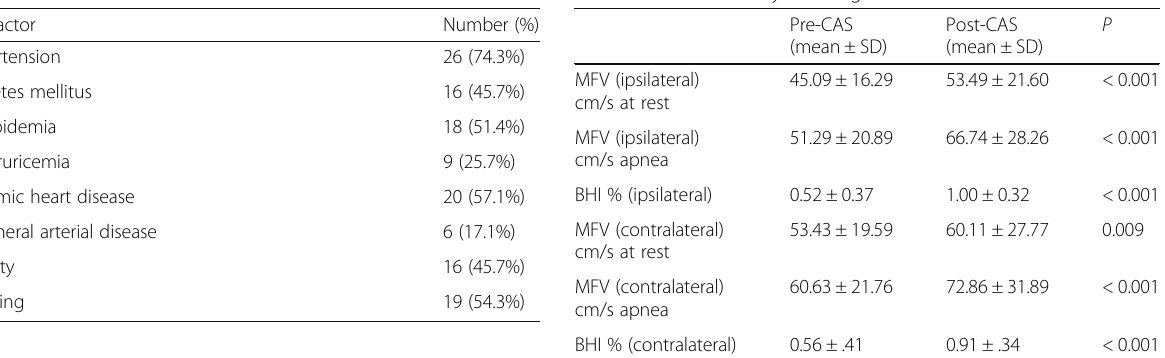
Table 3 Mean flow velocity and breath holding index before and after carotid artery stenting